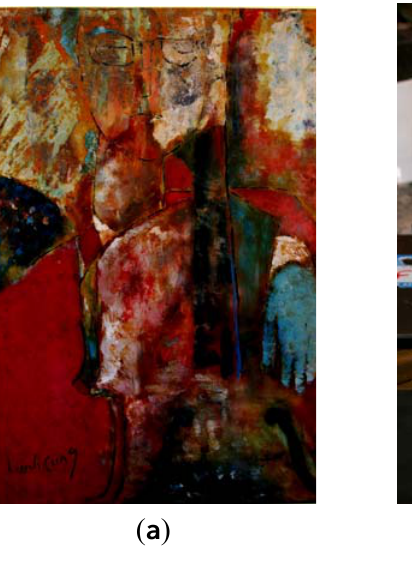
Figure 3. Lacquerware masterpieces: ( a ) Tranh Cung and ( b ) a decorative production analysed with mobile Raman